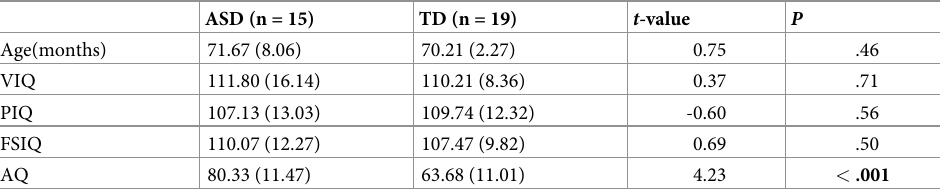
Note: Specific data on socioeconomic status were not collected in the current